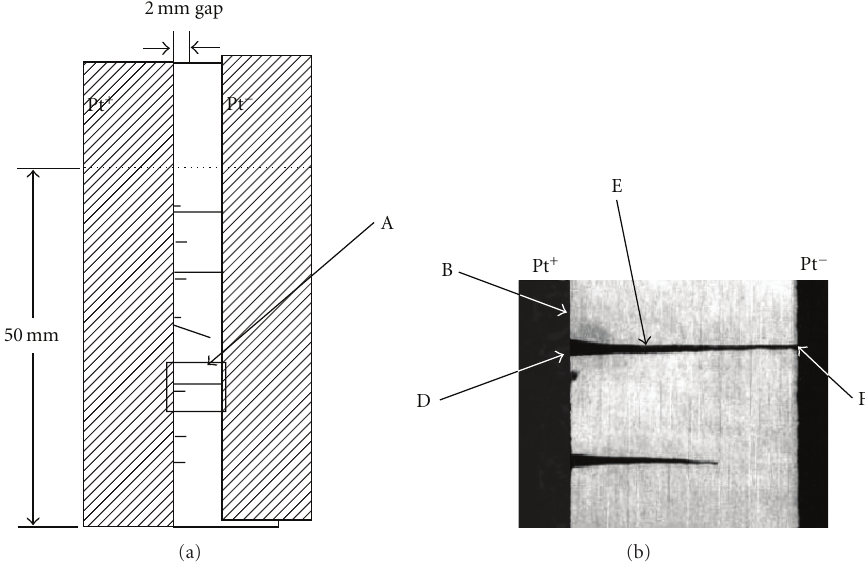
Figure 3: A schematic view (a) of a sample after electrooxidative polymerization. A micrograph taken after the polypyrrole decoration (b) at the position A indicated in (a). It is observed that the electric path composed of polypyrrolyl conjugate bonds grew from the Pt + electrode by electrooxidative polymerization.